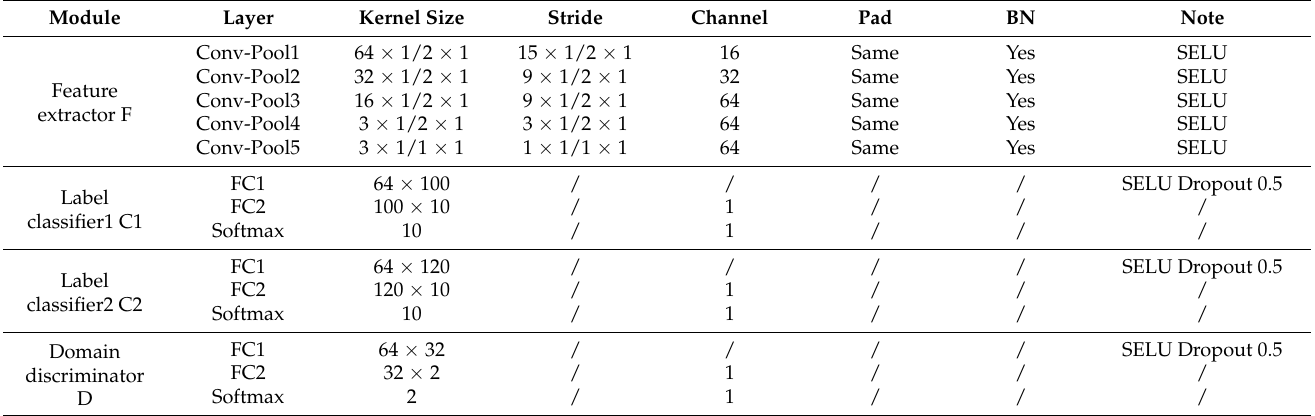
Figure 3. Basic frame diagram of DAN-DAM model. Table 1. The parameters configuration of DAN-DAM